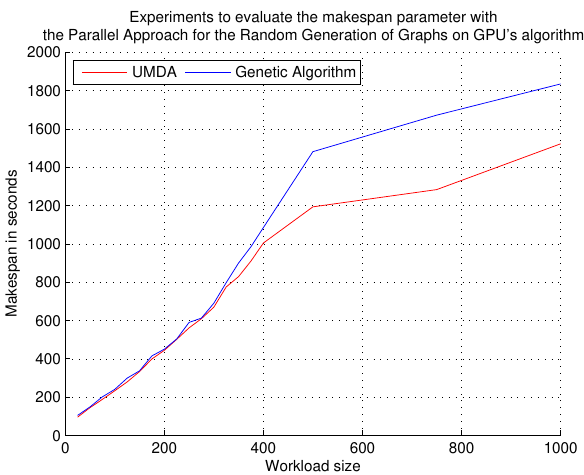
Figure 5. Results of makespan parameter with the parallel approach for the random generation of graphs on GPUs algorithm.